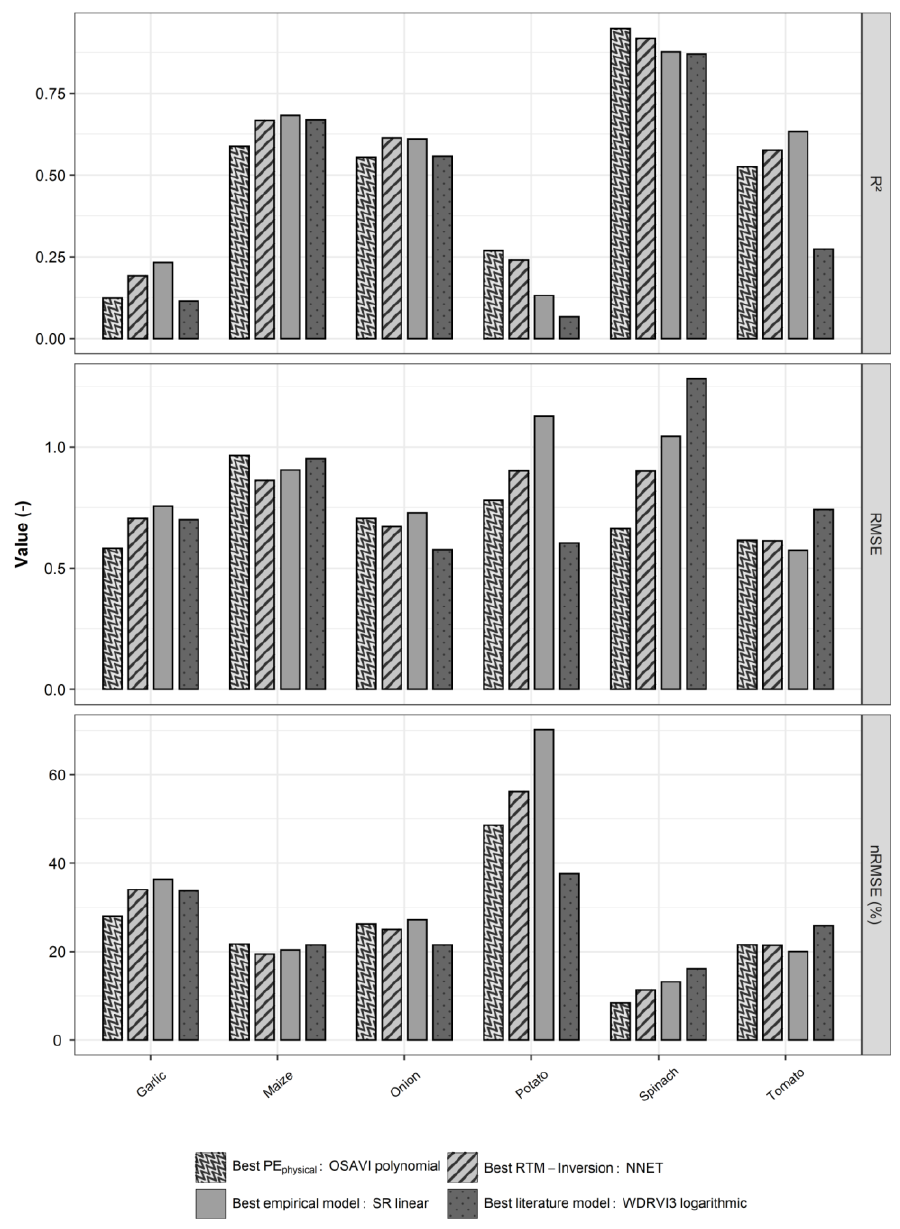
Figure 7. R 2 , RMSE, and nRMSE (%) of the best model one for each LAI retrieval method according to different crops (Garlic, Maize, Onion, Potato, Spinach, and Tomato). Best empirical model: linear regression between LAI and SR; best RTM-inversion: NNET; best literature model: WDRVI3-based model provided by [52] ; best PE physical model: based on OSAVI-second-order polynomial fitting.